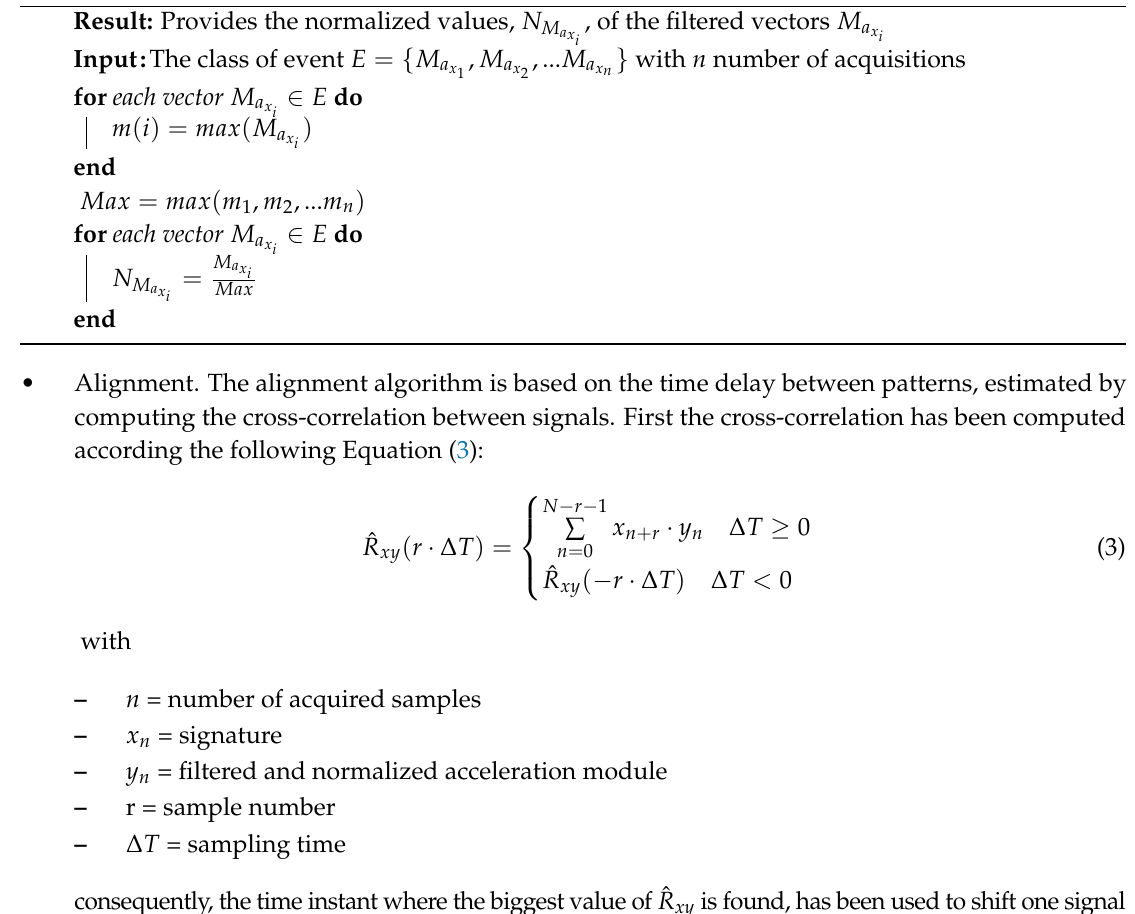
Algorithm 1: Normalization algorithm